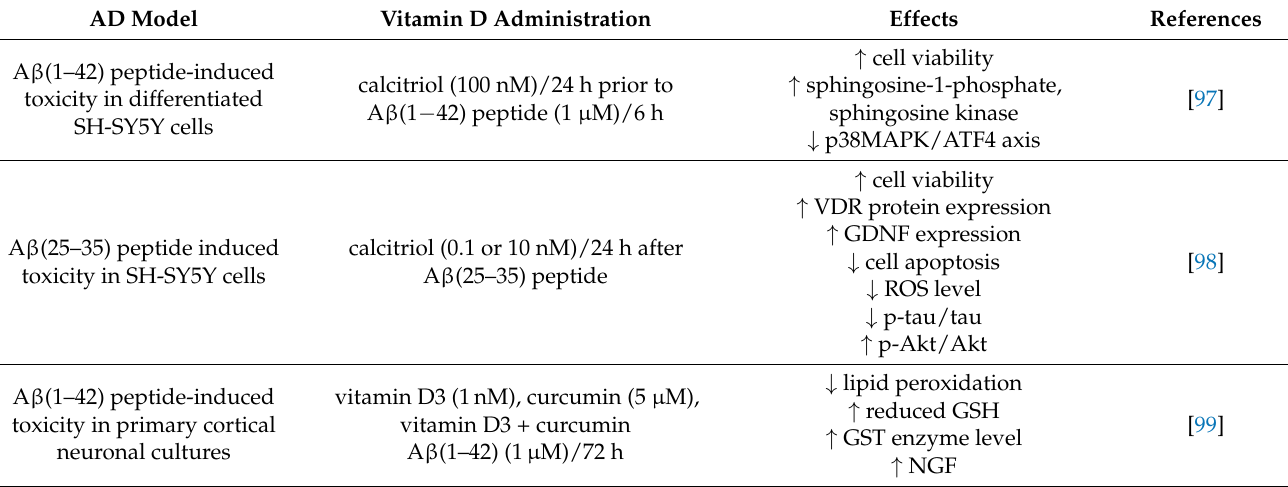
Table 1. Effects of vitamin D in experimental models of Alzheimer disease—in vitro